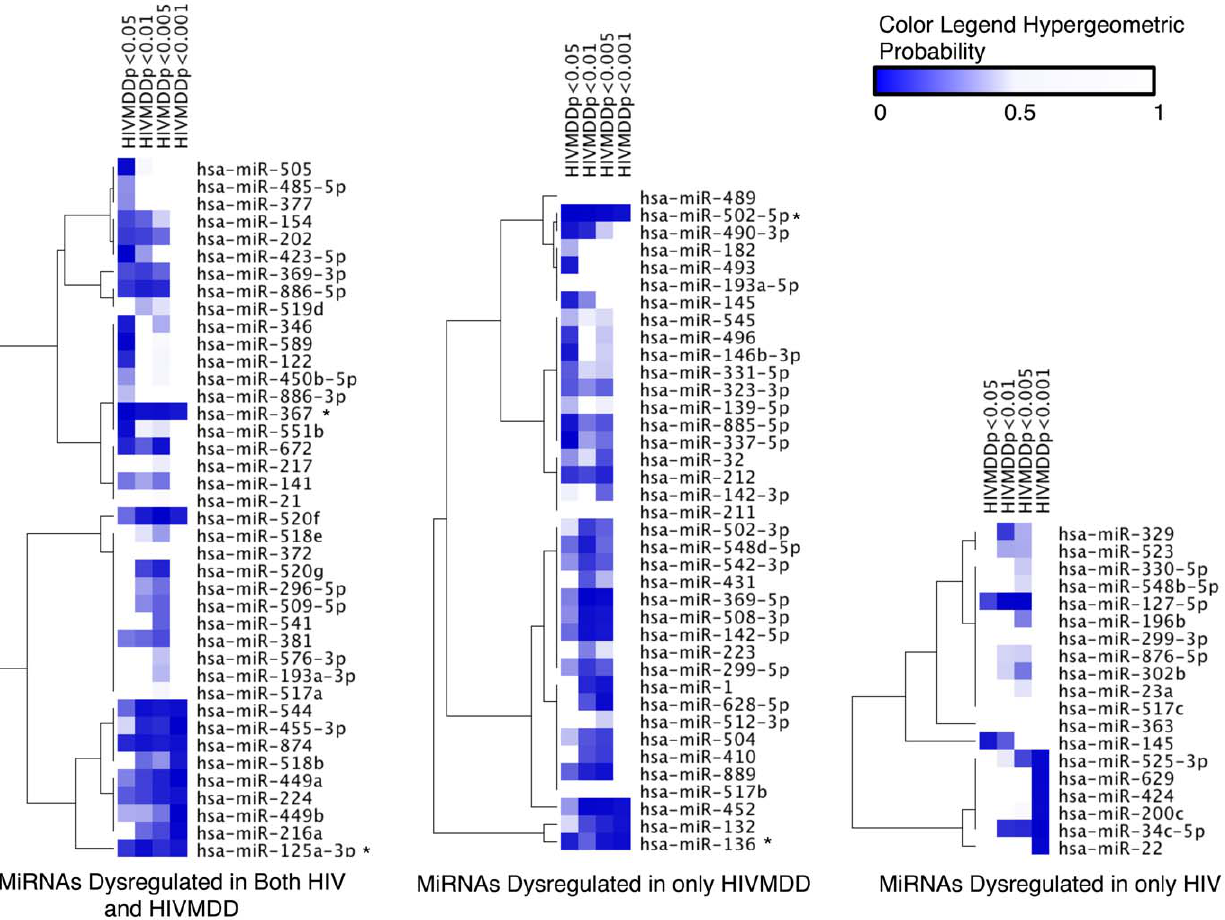
Figure 3. Target Bias analysis of a subset of miRNAs from frontal cortex in HIV and HIV/MDD conditions. MiRNAs dysregulated at least twofold in HIV or HIV/MDD are analyzed. Four windows of analysis are depicted: mRNAs dysregulated in HIV or HIV/MDD at p , 0.05, p , 0.01, p , 0.005, and p , 0.001. For each window, a list of dysregulated mRNAs is generated (n) from the Affymetrix U133 Plus 2.0 array (containing probes for N unique genes) which calculated relative quantification (RQ) of gene expression in Condition vs Control, data shown in Table S2. For each miRNA, a list of all targets present on the array is generated (m); from that list of targets, the number k targets are found to be significantly dysregulated within each of the four windows. Using cumulative hypergeometric distribution from SPSS software [41], we calculated the probability that k targets would be dysregulated from a list of size n genes, given that there are m targets on the gene array of the population N genes. (Using the function: P=1-cdst.hypergeo(k,n,N,m) in SPSS). The color scale depicts the probability for target bias for each of 97 miRNAs and corresponding windows, with dark blue to white indicating 0.0 , P , 0.5. The miRNAs were sorted by their target biases using Hierarchical Clustering algorithm of Genepattern software. The gene expression in HIV/MDD of genes which are targets of miRNAs that show significant target bias is illustrated in Figure 4.